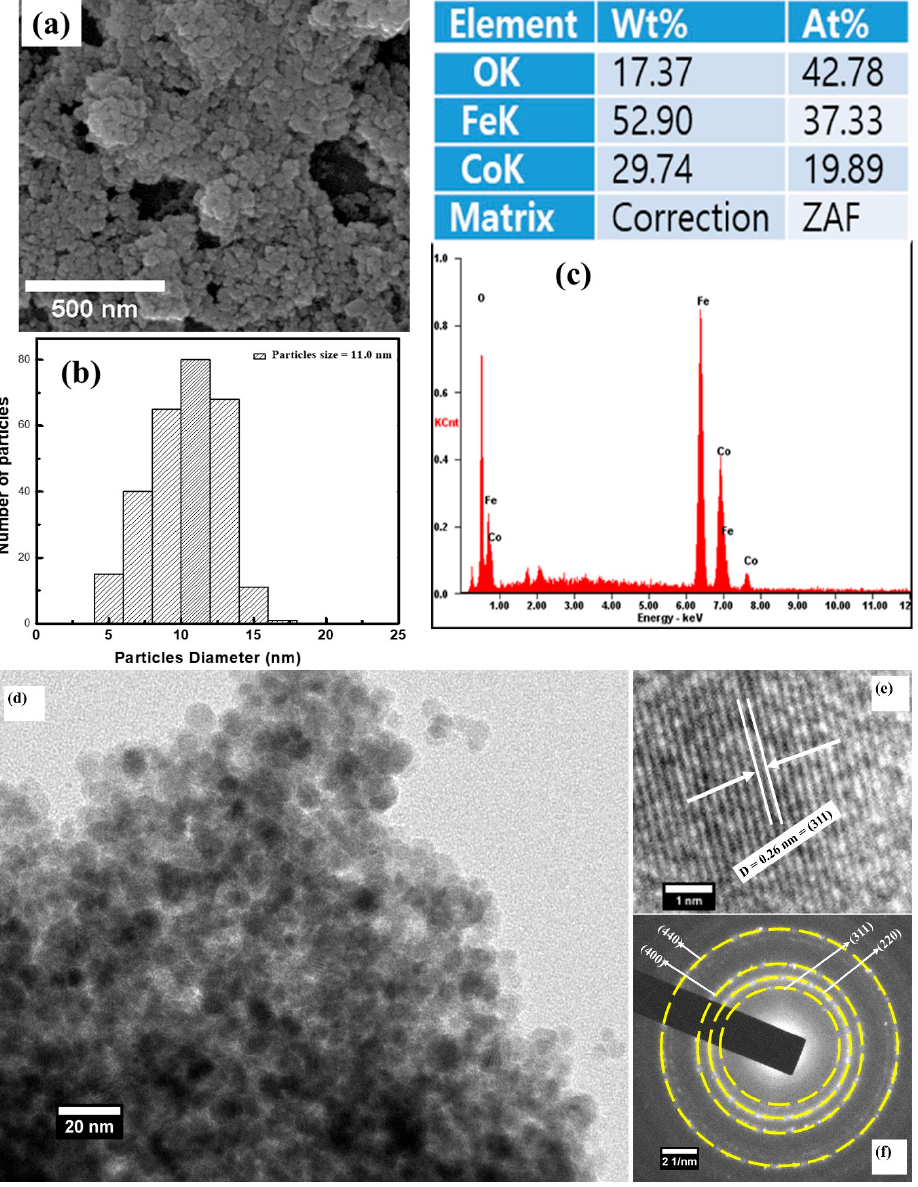
Figure 2. ( a ) Field emission scanning electron microscopy (FE-SEM) micrograph of CeFe 2 O 4 nanostructures, ( b ) particle size distribution histogram of CeFe 2 O 4 nanostructures, ( c ) energy-dis- persive X-ray spectroscopy (EDS) spectrum of CoFe 2 O 4 nanostructures and the stoichiometry (%) of constituent elements present in CeFe 2 O 4 nanostructures. ( d ) Transmission electron microscopy (TEM) micrograph of CeFe 2 O 4 nanostructures, ( e ) high-resolution transmission electron microscopy (HR-TEM) micrograph of CeFe 2 O 4 nanostructures, ( f ) selective area electron diffraction (SAED) pat- tern of CeFe 2 O 4 nanostructures.